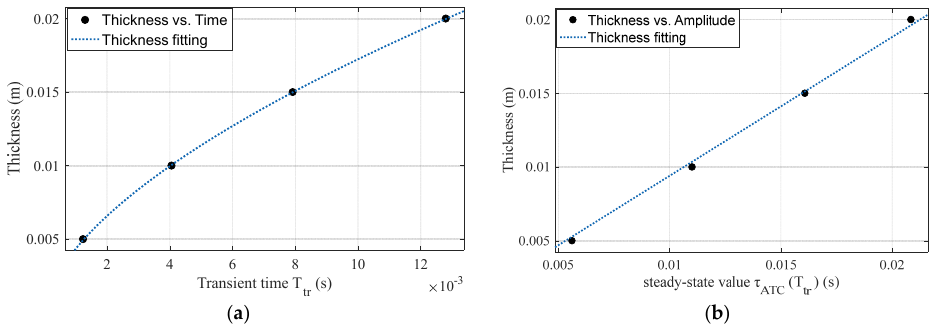
Figure 6. Fitting results of aluminum plate thickness. ( a ) The relationship between the thickness of the aluminum plate and the transient time follows the power law. ( b ) The thickness of the aluminum plate has a linear relationship with the steady-state value of the D-ATC curve.